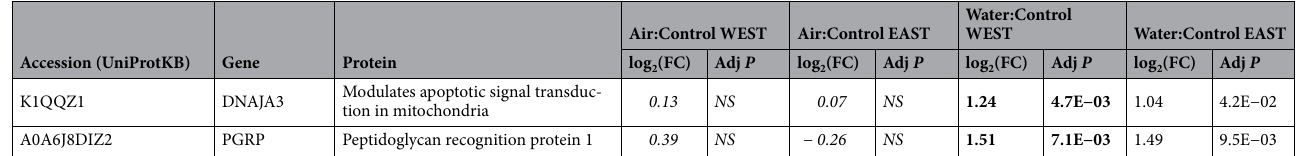
Table 1. Comparative expression of molecular chaperones/co-chaperones involved in the heat stress and the unfolded protein response following exposure to AIR and WATER in Western and Eastern P. perna lineages. All accessions were significantly upregulated in response to WATER (not AIR when indicated by NS). The greatest fold-change values (log2, bold) by lineage within each treatment are indicated, together with BH-adjusted P values. Significant values are in italics.